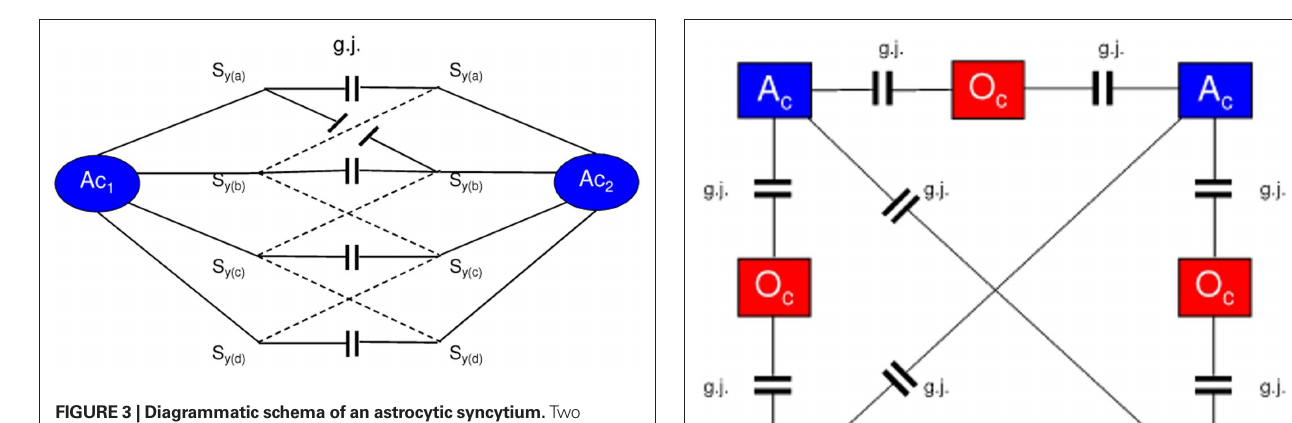
Figure 3 | Diagrammatic schema of an astrocytic syncytium. Two astrocytes (Ac , Ac ) are interconnected via gap junctions (g.j.). Each astrocyte 1 2 contacts four synapses (S ) with four different qualities (a, b, c, d) building two y astrocytic-neuronal compartments. Since these two compartments are interconnected via gap junctions, a network is generated, called syncytium.